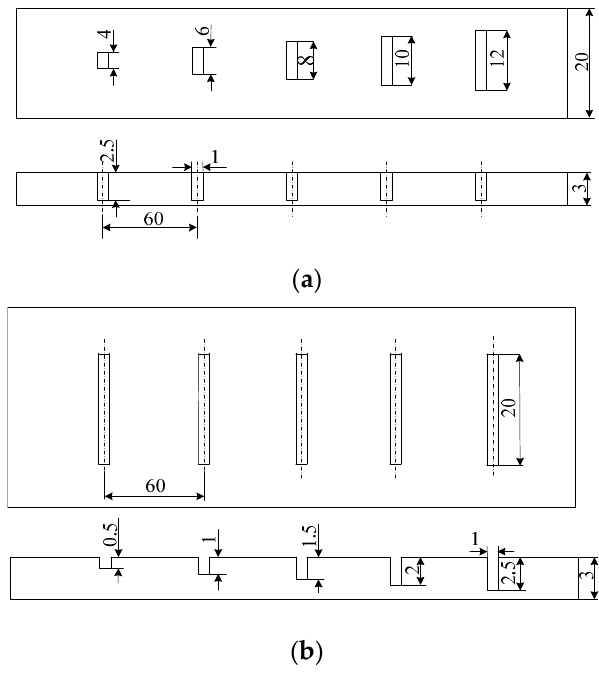
Figure 2. Fabricated specimens. ( a ) Sample 1: Defects with different lengths; ( b ) Sample 2: Defects with different depths. Table 1. Parameters of the defects.